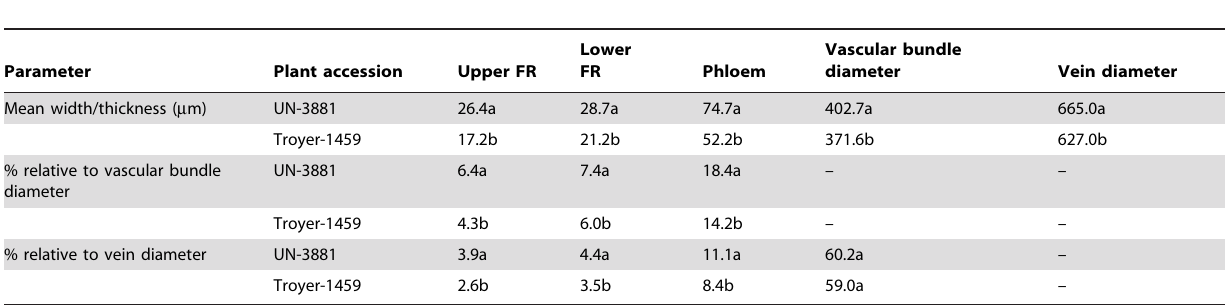
Table 4. Morphometrics of the fibrous ring (FR), phloem, and vascular bundle in leaf midrib sections of the relatively resistant (UN- 3881) and relatively susceptible (Troyer-1459) plants 1